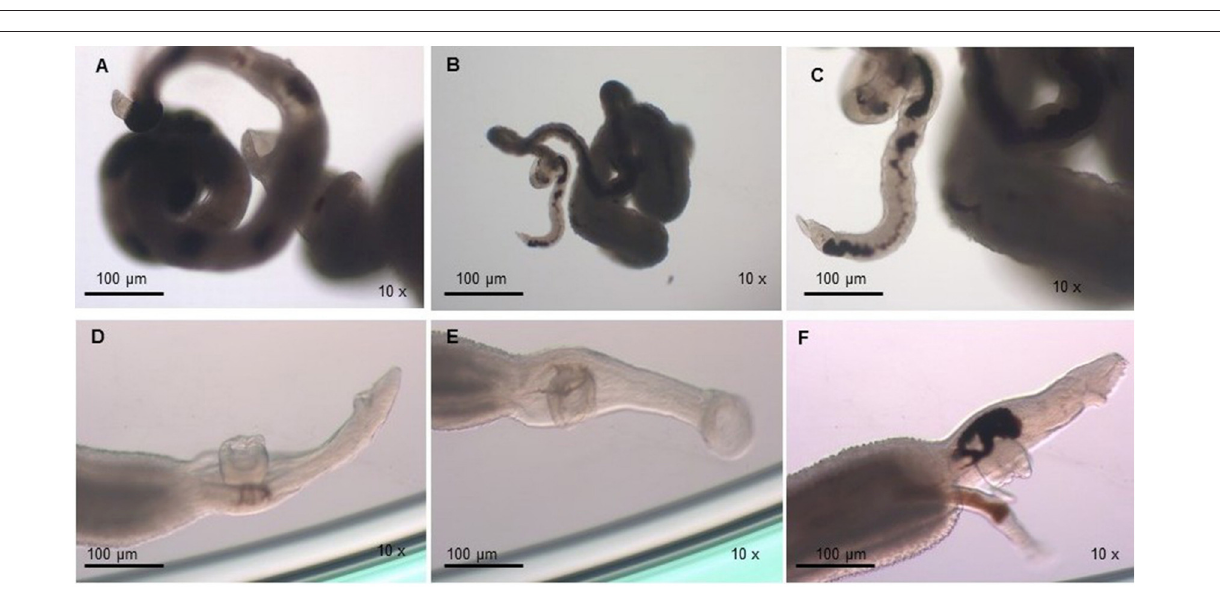
FIGURE 1 | Schematic cartoon of the experimental design. (1) Biomphalaria glabrata snails (intermediate hosts of S. mansoni ) release the infective form of the parasite (cercariae) for human or other mammalian definitive hosts; (2) about 100 cercariae were used to infect the definitive host; (3) CD1 Mice were used as definitive host in our experiment, and after 8–10 weeks post-infection they were sacrificed to collect adult worms of the parasite; (4) adult worms were obtained by mice liver perfusion; (5) male and female worms were treated in 24-well culture plate with a dosage of PZQ (0.3 µ M) with impact in the parasite but with the guarantee of not killing them. These worms were prepared for tegumental alterations study using SEM; (6) couple worms were treated in 24-well culture plate with a lethal dosage of PZQ (32 µ M). These worms were analyzed and monitored under an inverted optical microscope.